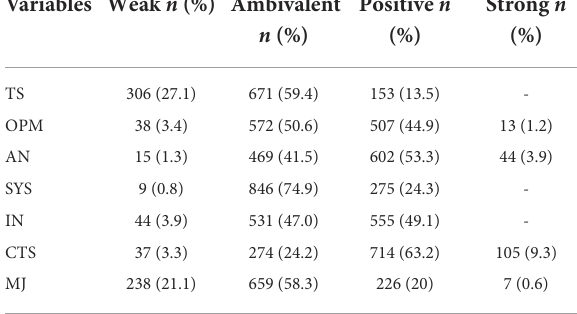
TABLE 2 Frequencies and percentages of distributions regarding dependent variables being